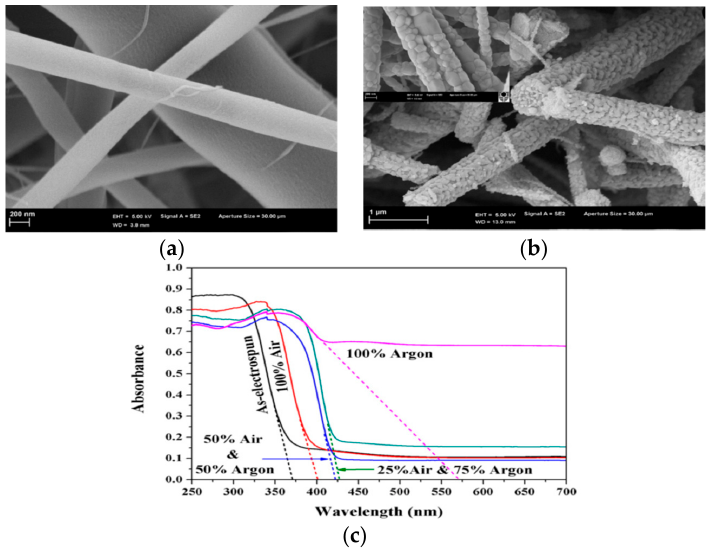
Figure 15. Scanning electron micrographs of ( a ) electrospun titania nanofibers before heating, and ( b ) after heating in 100% argon atmosphere at 900 °C. ( c ) UV-visible spectra of as-spun titania nanofibers without calcination, and with calcination at 900 °C in 100% air, 50% air–50% argon, 25% air–75% argon and 100% argon. Reproduced with permission from [233]. Copyright Elsevier, 2016.